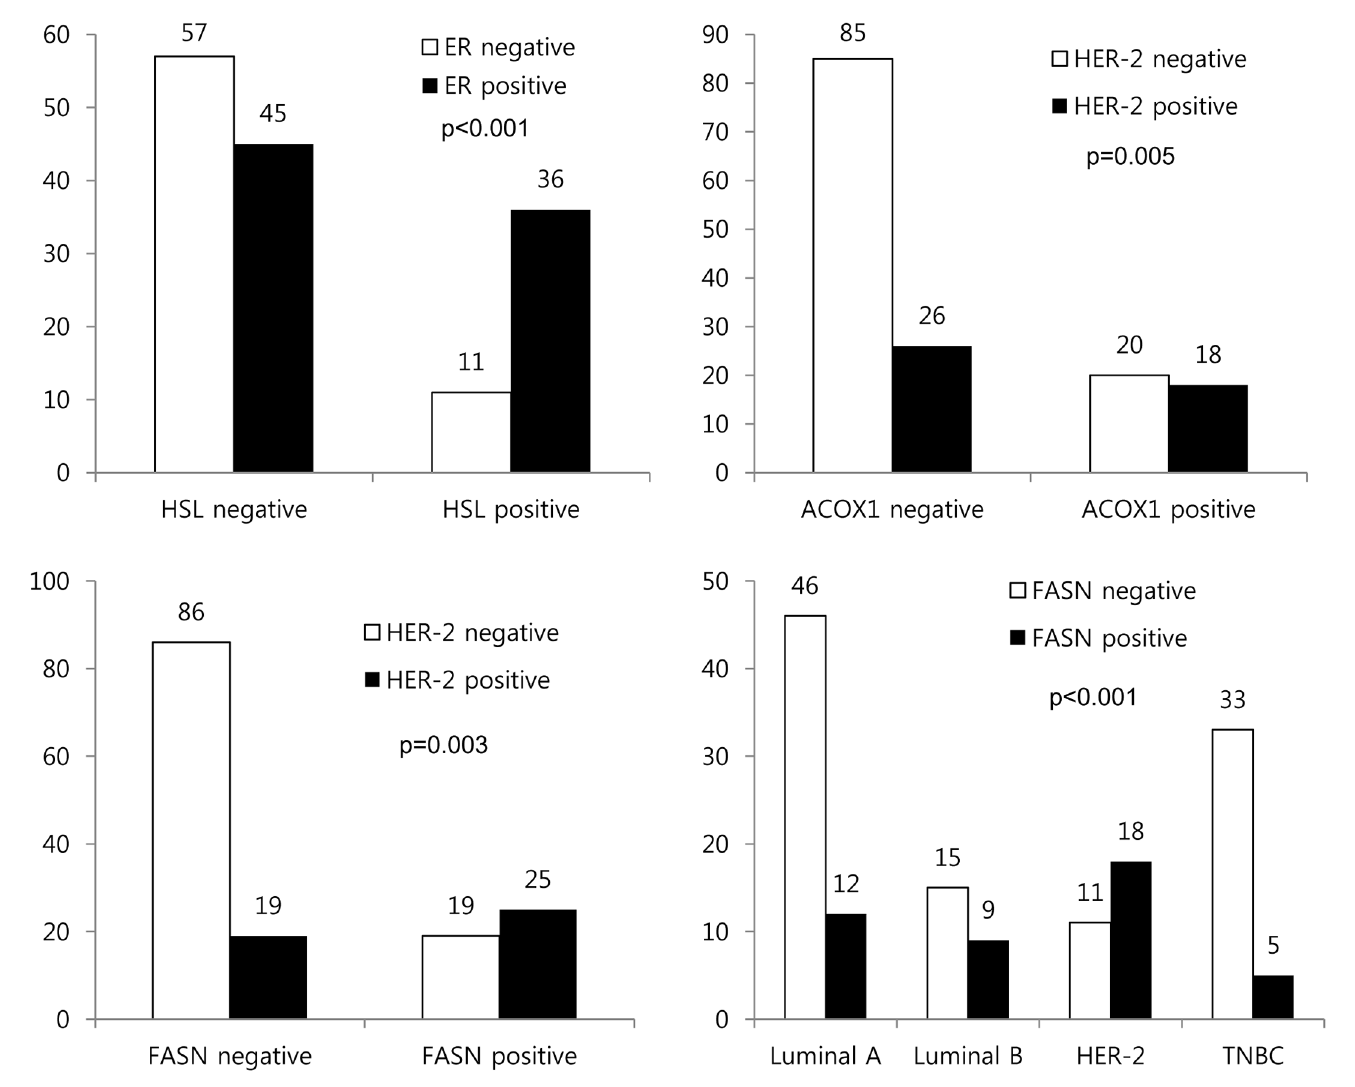
Fig 2. Correlation between pathologic factors and expression of lipid metabolism-related